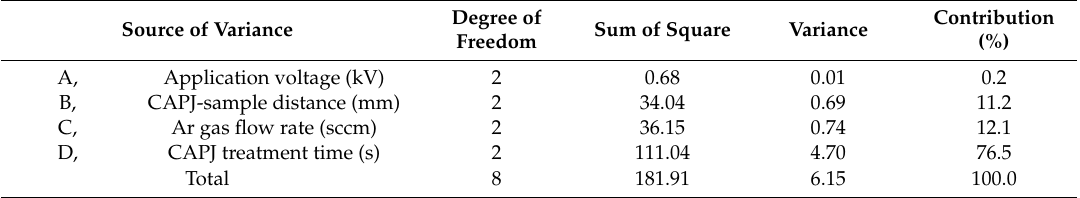
Table 5. Summary of the ANOVA results for the bactericidal activity of E. coli by CAPJ.